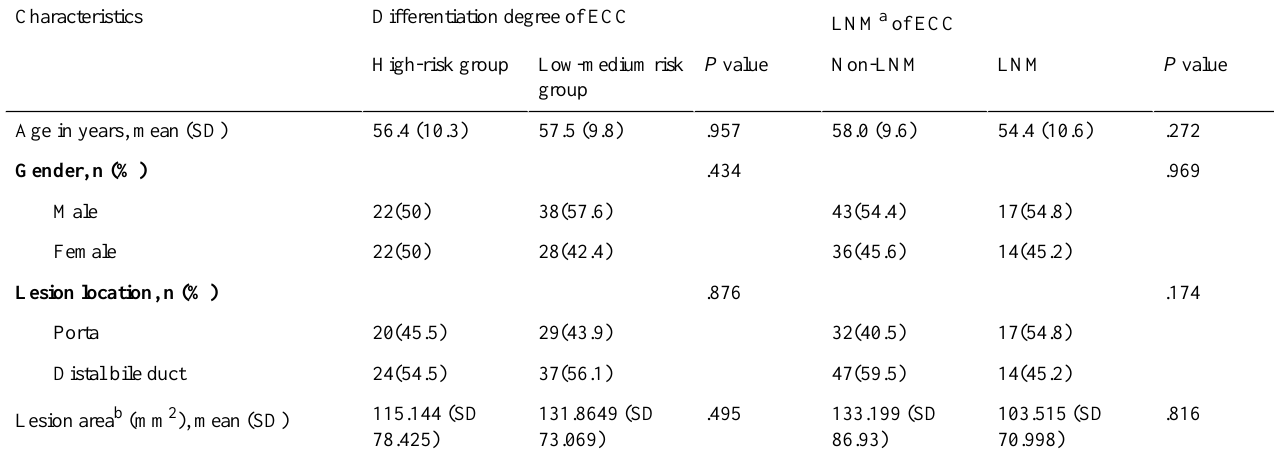
Table 2. Clinical and pathological characteristics of patients with extrahepatic cholangiocarcinoma (ECC;